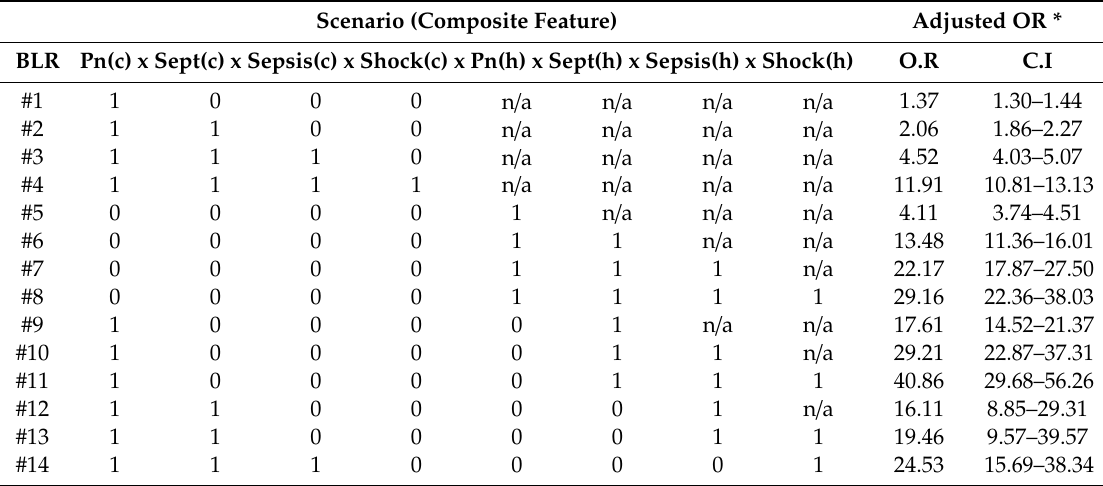
Table 6. Binary logistic regression to study the e ff ect of bloodstream infection scenarios on hospital